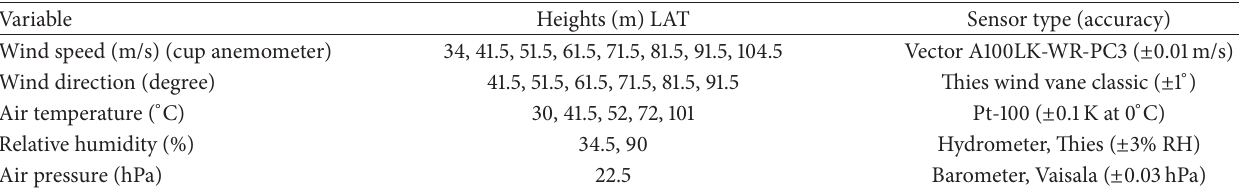
Table 1: Meteorological parameters with their associated heights and the sensor types including their accuracy [6] at the FINO1 offshore platform.